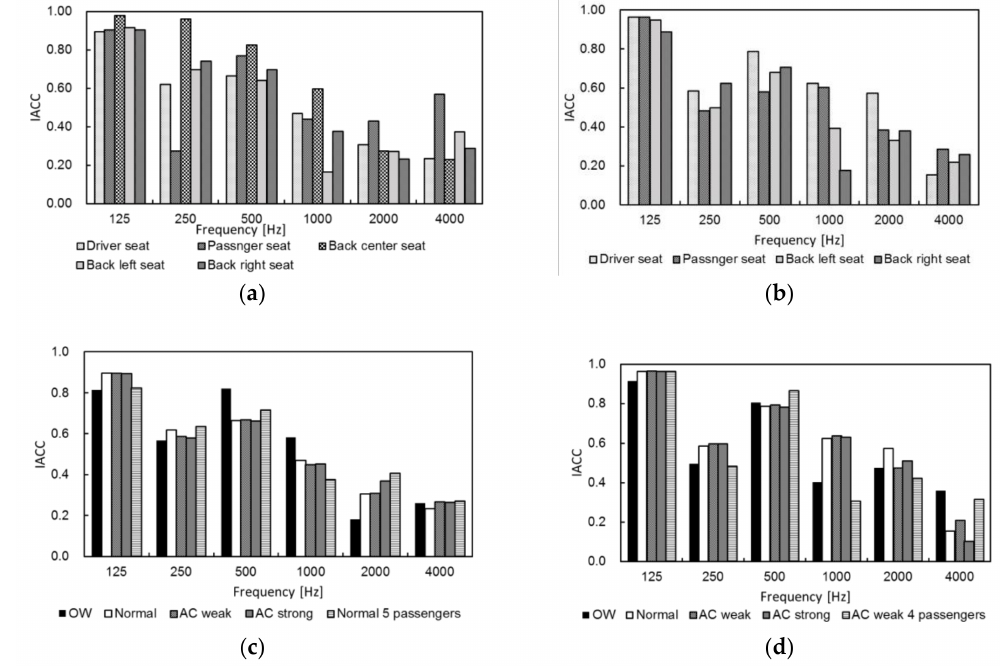
Figure 7. Measured inter-aural cross correlation ( IACC ) at each passenger position in cars ( a ) A and ( b ) B and under open-window (OW) and air-conditioner (AC) settings in cars ( c ) A and ( d ) B.